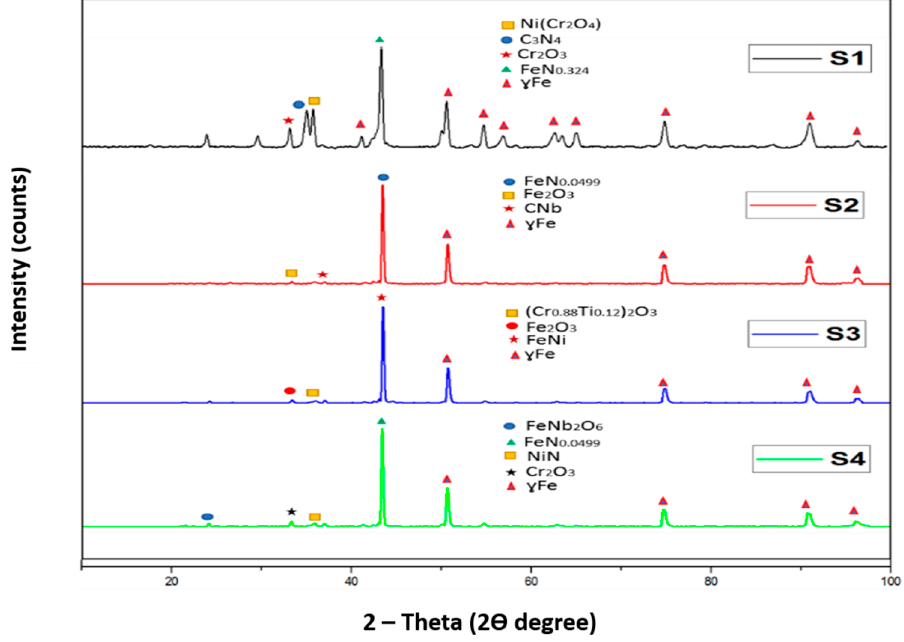
Figure 8. XRD analyses of sintered samples.